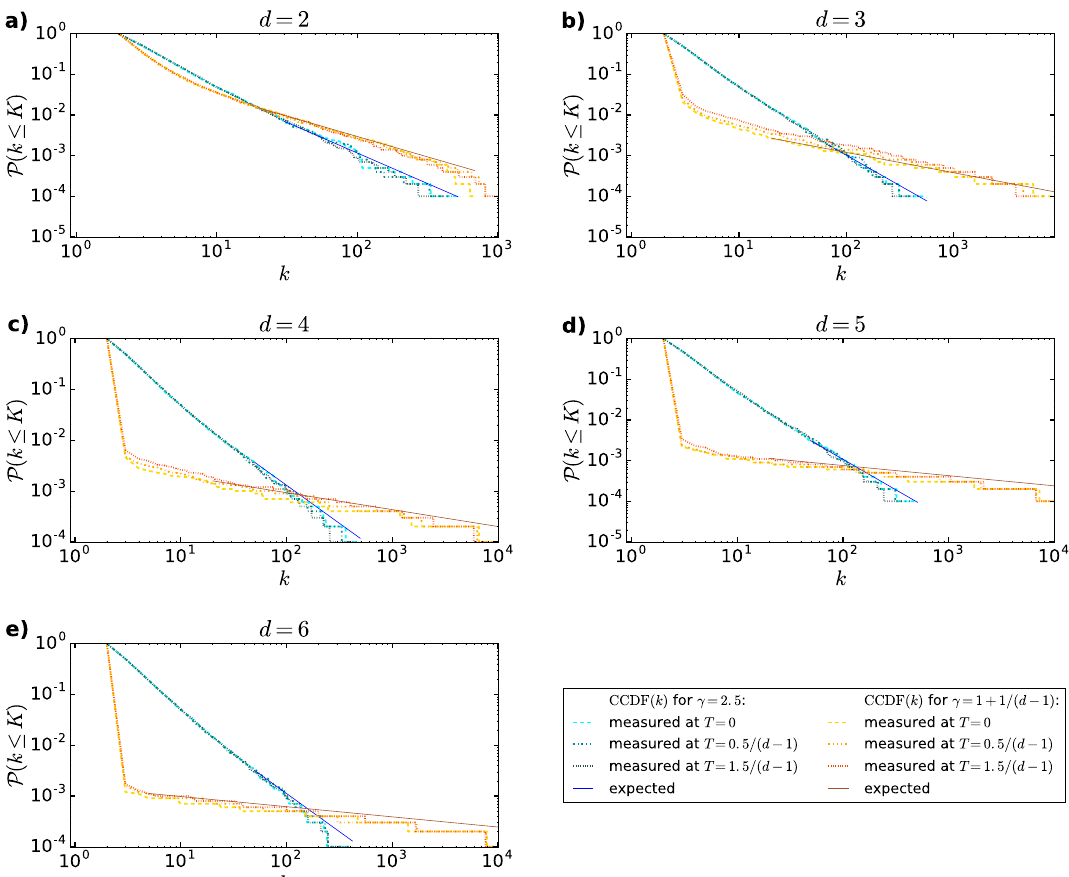
Figure 2. Degree distribution of networks generated by the d PSO model at different parameter settings. Panels a – e correspond to different dimensions d from 2 to 6. We display in all the panels the complementary cumulative distribution function (CCDF) of the node degrees for networks of two different degree decay 2.5 (blue) and γ 1 1 /( d 1 ) (orange). In both cases, we generated a network using the exponents: γ = = + − 0 (dashed lines), T 0.5 /( d 1 ) (dash-dotted lines) or T 1.5 /( d 1 ) (dotted lines). temperature setting T = = − = − The curvature of the hyperbolic space, the number of nodes and the half of the expected average degree were 2 . All the indicated simulation results 10, 000 and m 1 , N ζ 2 the same for all networks, namely K = = = − = − 1 ) (shown by solid lines) that was expected based on the analytical K ) k (γ match well the curve P ( k − − ≤ ∼